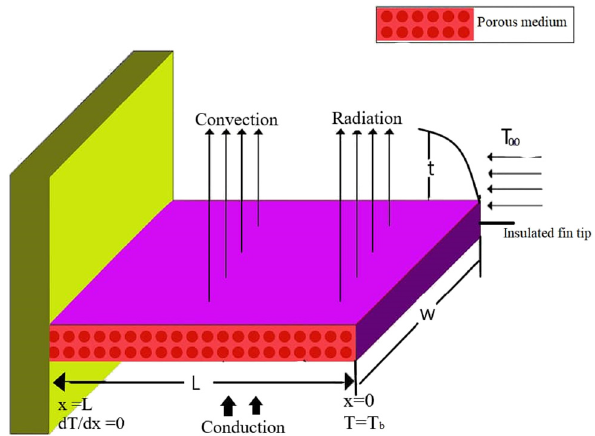
Figure 1: Physical system of the fi